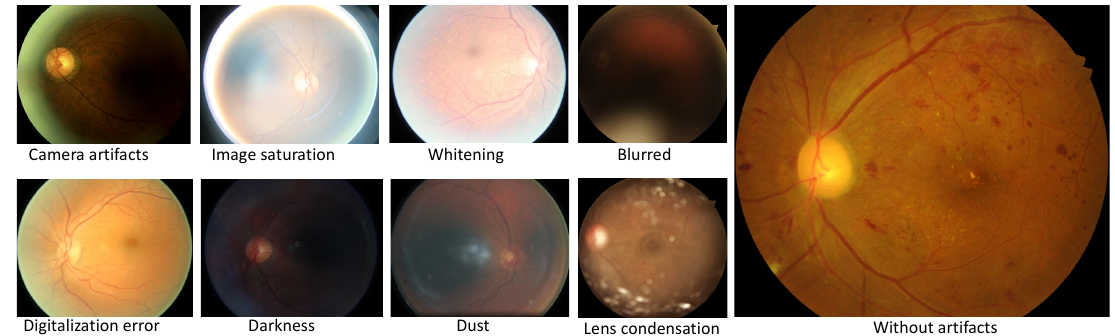
Figure 1. Various artifacts of the optical coherence tomography camera for the Eye Picture Archive Communication System (EyePACS) dataset. We cleaned the datasets from such defects, and these images are cropped from the original datasets.